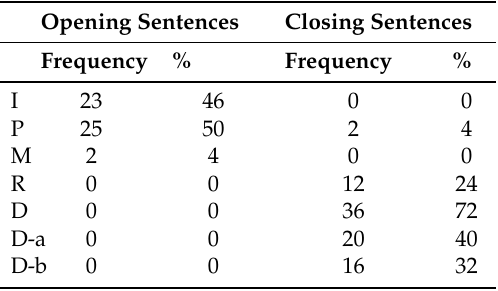
Table 8. Distribution of opening and closing sentences ( n =